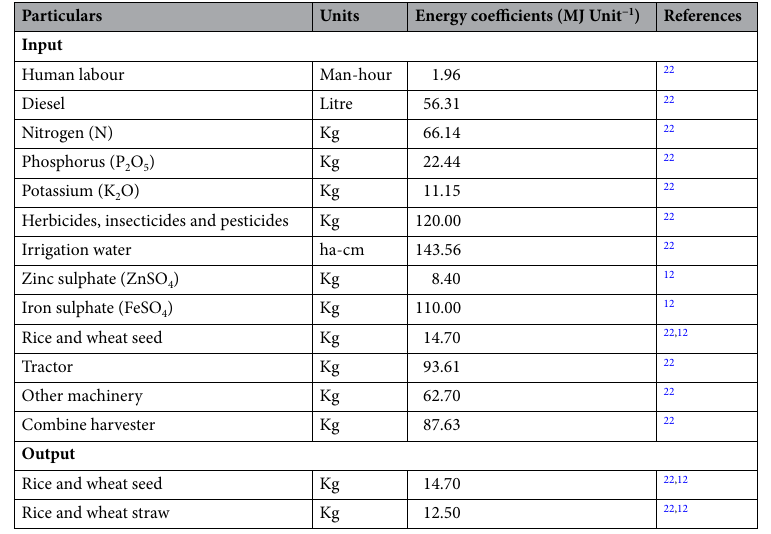
Table 6. Energy equivalents used in the study for different agricultural operations.